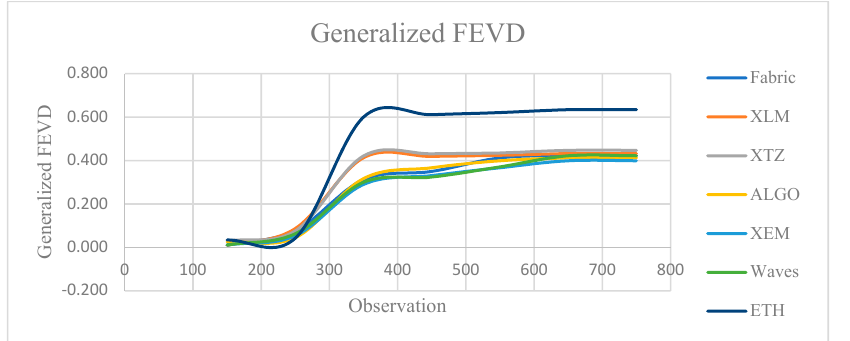
Figure 6. Generalized forecast error variance decomposition (GFEVD) for the smart contracts through QVAR.